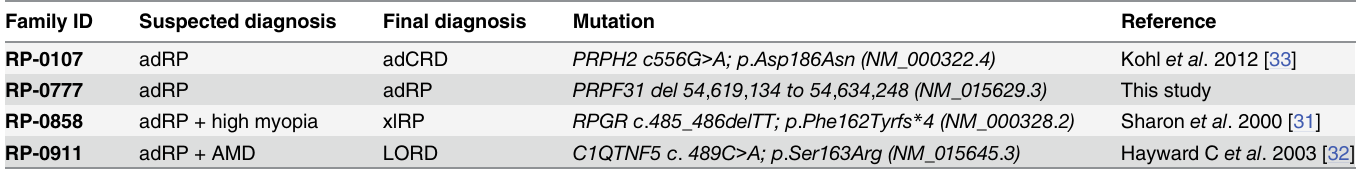
Table 3. Mutations detected in the four families included in the study. adRP: autosomal dominant Retinitis Pigmentosa; AMD: age-related macular degeneration; adCRD: autosomal dominant cone-rod dystrophy; LORD: Late-onset retinal degeneration. Family